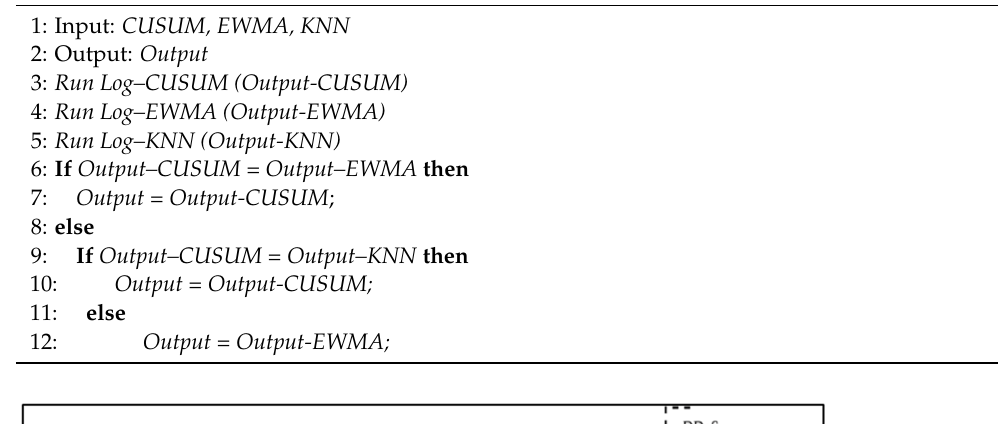
Algorithm 1: Proposed Algorithm Advantages of Backup